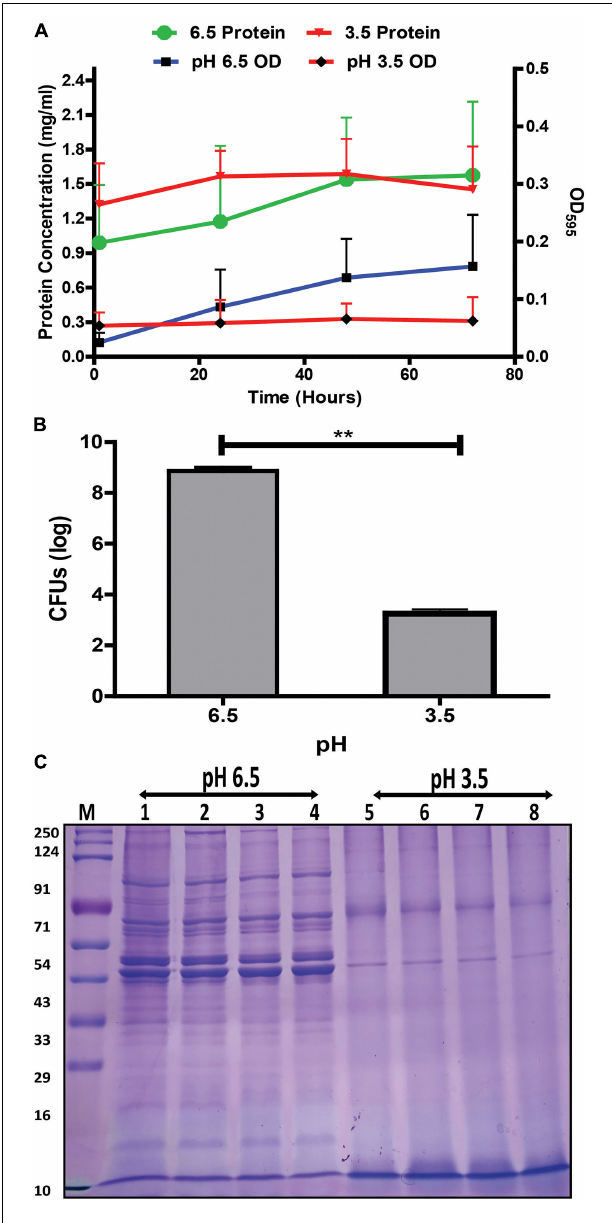
FIGURE 1 | Effect of pH on the growth and protein profile of G. vaginalis ATCC 14019. (A) Changes in growth and protein concentration of G. vaginalis at pH 6.5 and 3.5 over time (1, 24, 48, and 72 h); data are presented as mean ± SD ( n = 3). No statistical significance was observed upon analysis by two-way ANOVA with Bonferroni test. (B) Reduction in colony forming unit (CFUs) of G. vaginalis at pH 3.5 compared to pH 6.5 after 48 h; data are presented as mean ± SD ( n = 2). Data was analyzed using student’s unpaired t test (** p < 0.01). (C) Time dependent (1, 24, 48, and 72 h) changes in protein profile of whole cell lysate of G. vaginalis at pH 6.5 and 3.5.